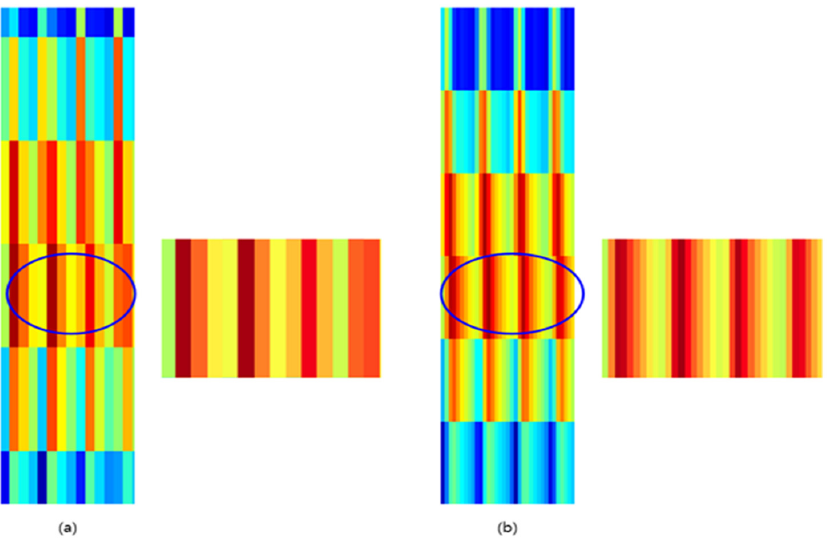
Figure 18. Comparison of ( a ): overlap 50% and ( b ): overlap 80%.